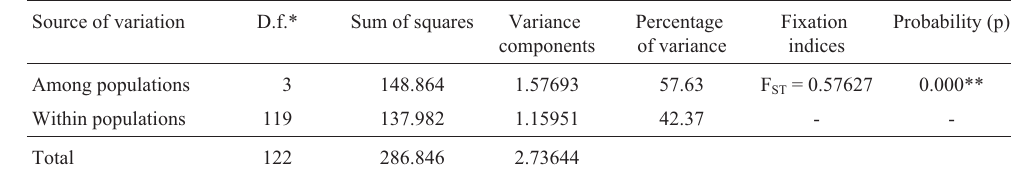
Table 4 - AMOVA results considering one group with four populations (Canela Island, Prainha, Camurupim and Acupe populations).